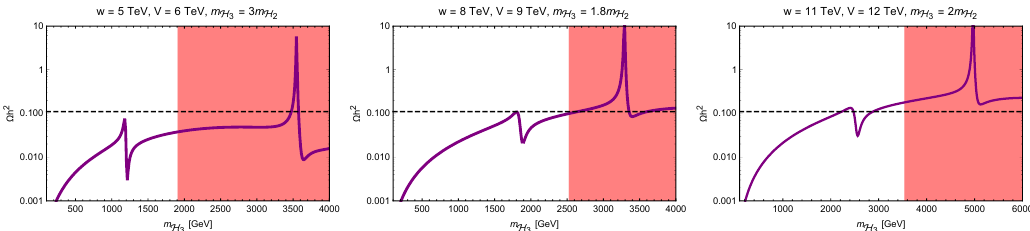
Figure 11 . The relic density of two-component scalar dark matter as a function of dark matter masses for the case m > m , where the dark matter unstable regime (red) is also H 3 H 2